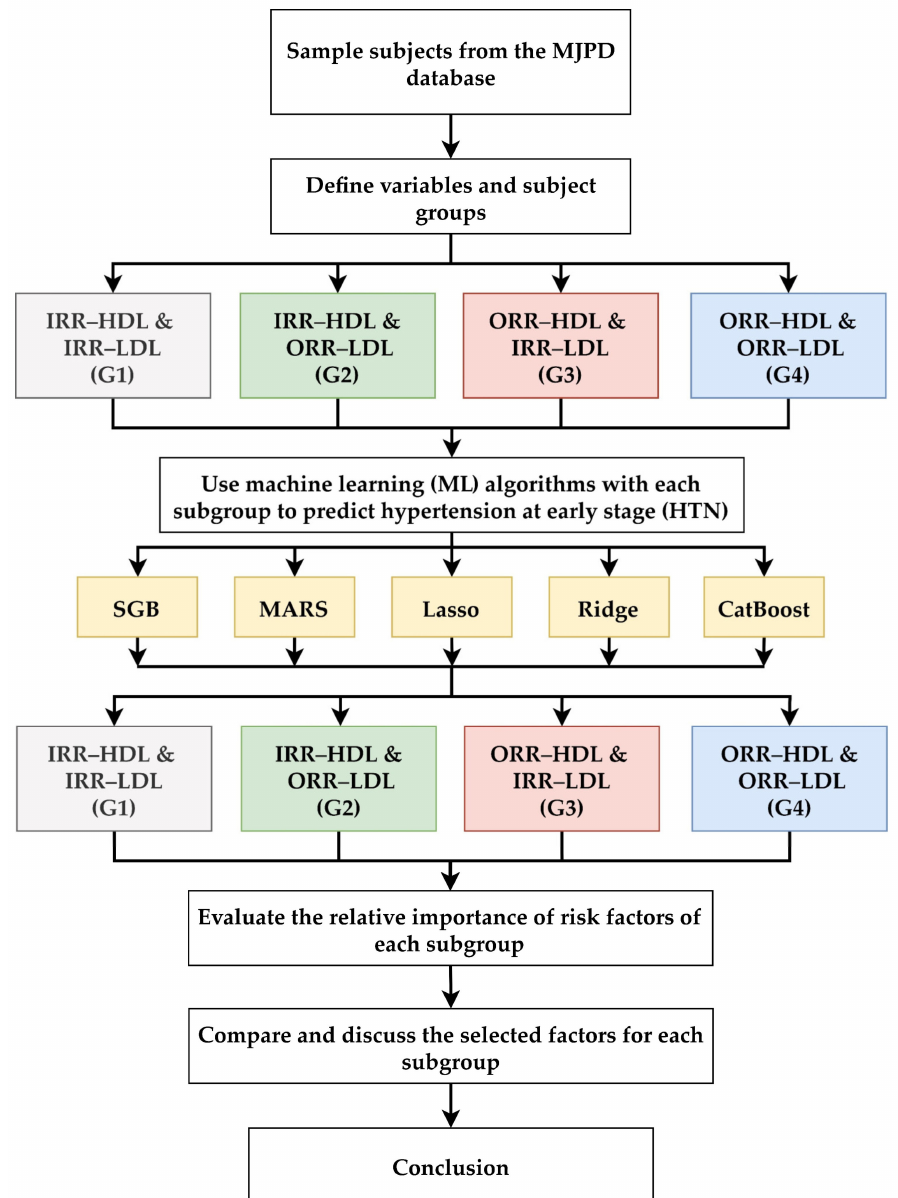
Figure 2. Proposed multi-stage machine learning algorithm-based